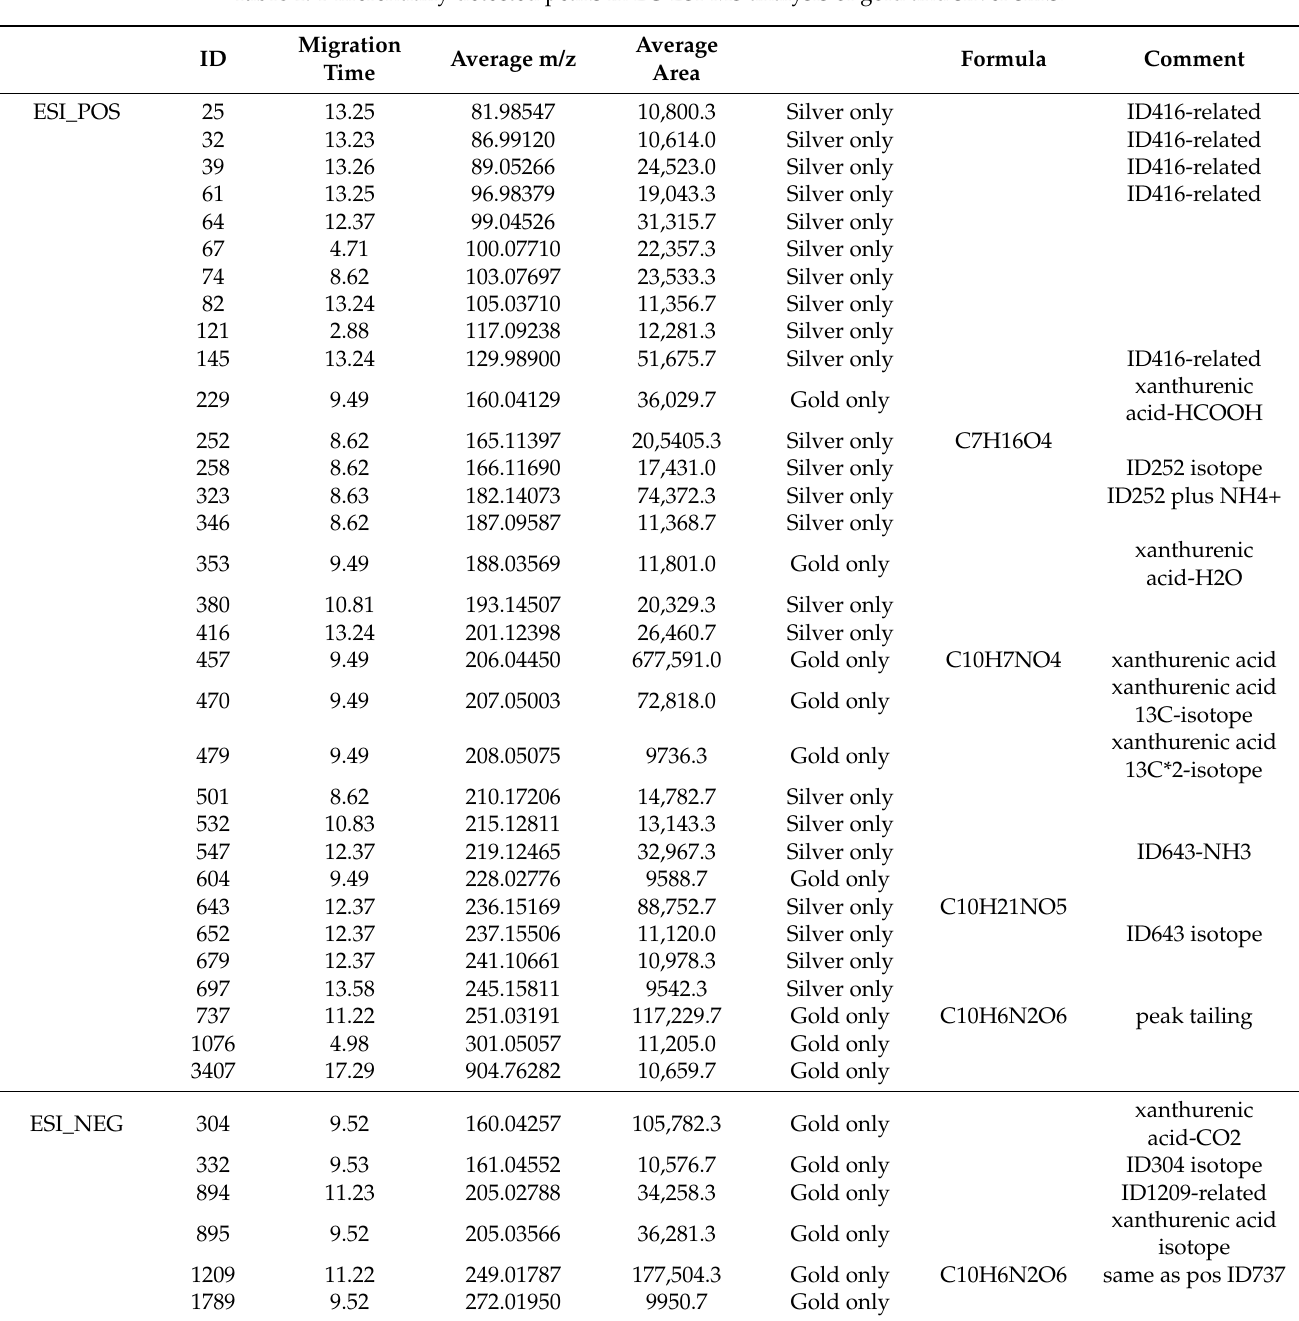
Table 1. Differentially detected peaks in LC-ESI-MS analysis of gold and silver